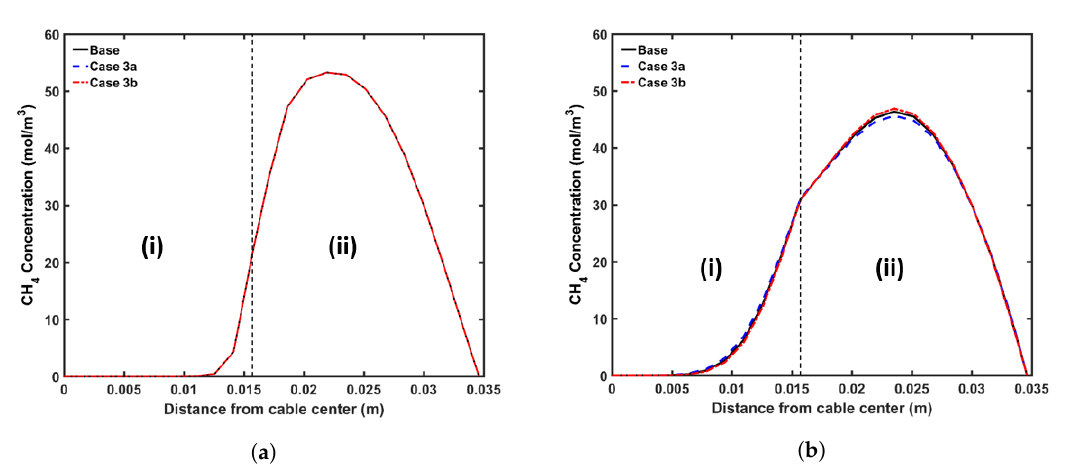
Figure 16. Radial CH 4 concentration profile for cooling-water flow rate study at ( a ) curing tube exit, ( b ) cable take-up point. Segment (i) corresponds to conductor layer and segment (ii) corresponds to the XLPE and SC